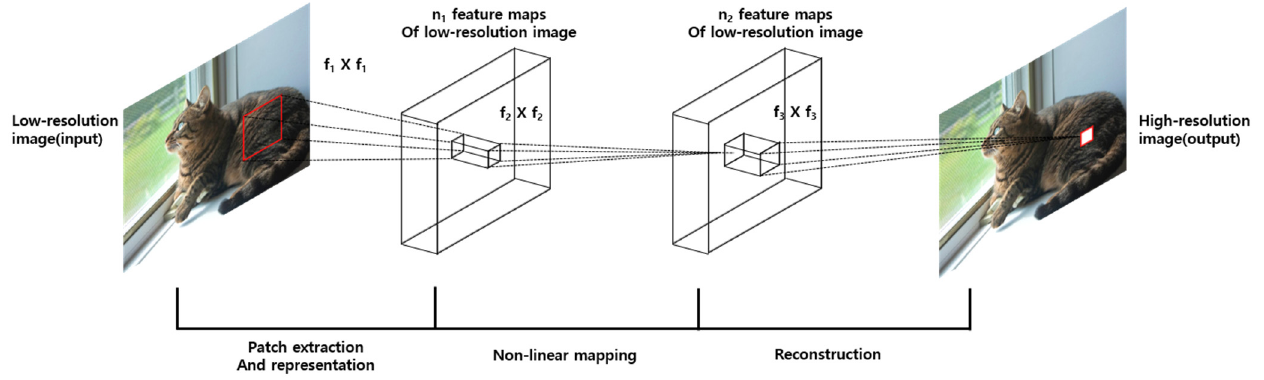
Figure 7. SRCNN structure.